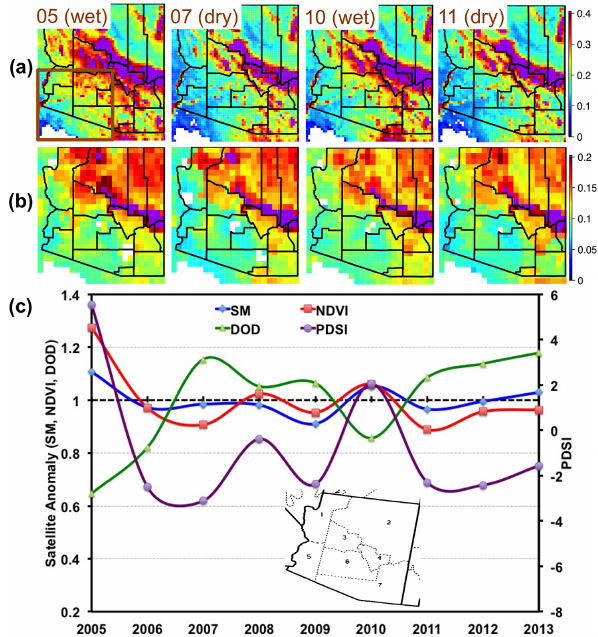
Figure 1. Inter-annual variability of drought indicators in dust sea- sons: (a) MODIS NDVI on 0.1 ◦ × 0.1 ◦ horizontal resolution and (b) ESA multi-sensor soil moisture (SM) product on 0.25 ◦ × 0.25 ◦ resolution are shown on selected moderate-to-severe dry and wet years. The text in the upper left corner of each panel indicates the year of the data. (c) Time series of PDSI and the anomalies (i.e., the annual mean value over the multi-year mean value) of satellite SM, NDVI and Aqua MODIS DOD. The anomalies of satellite data were calculated using data within the box defined in (a) . The inset panel in (c) shows the NOAA climate divisions, and PDSI values in the southwest (region 5) and south central (region 6) regions were used in the time series